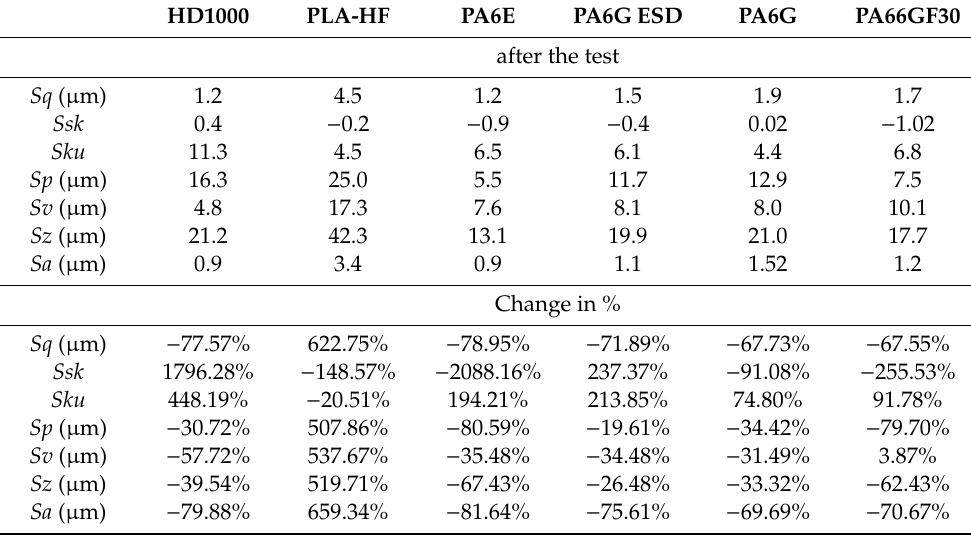
Table 11. Surface characteristics after the tests and the change in %.